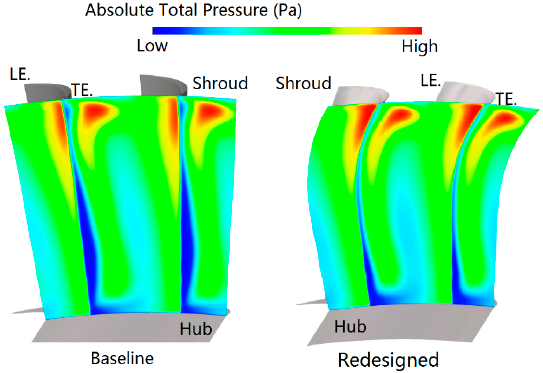
Figure 19. Total pressure contours downstream of the baseline and redesigned stator 5 (near the stall